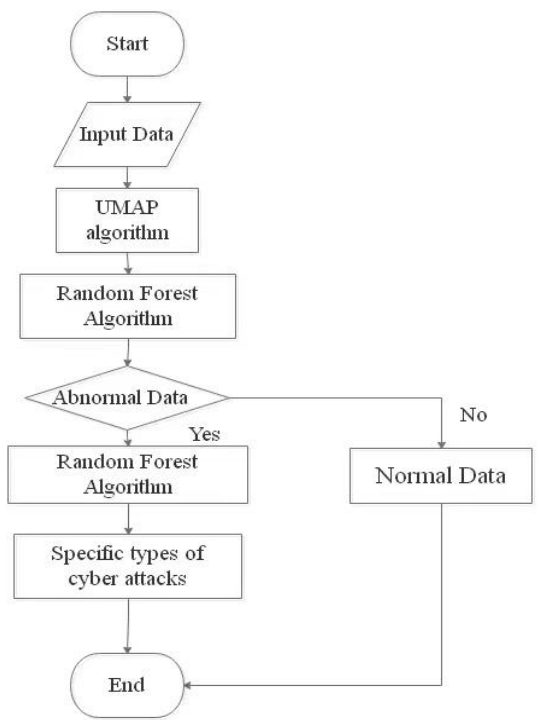
Figure 1. UMAP hybrid algorithm.